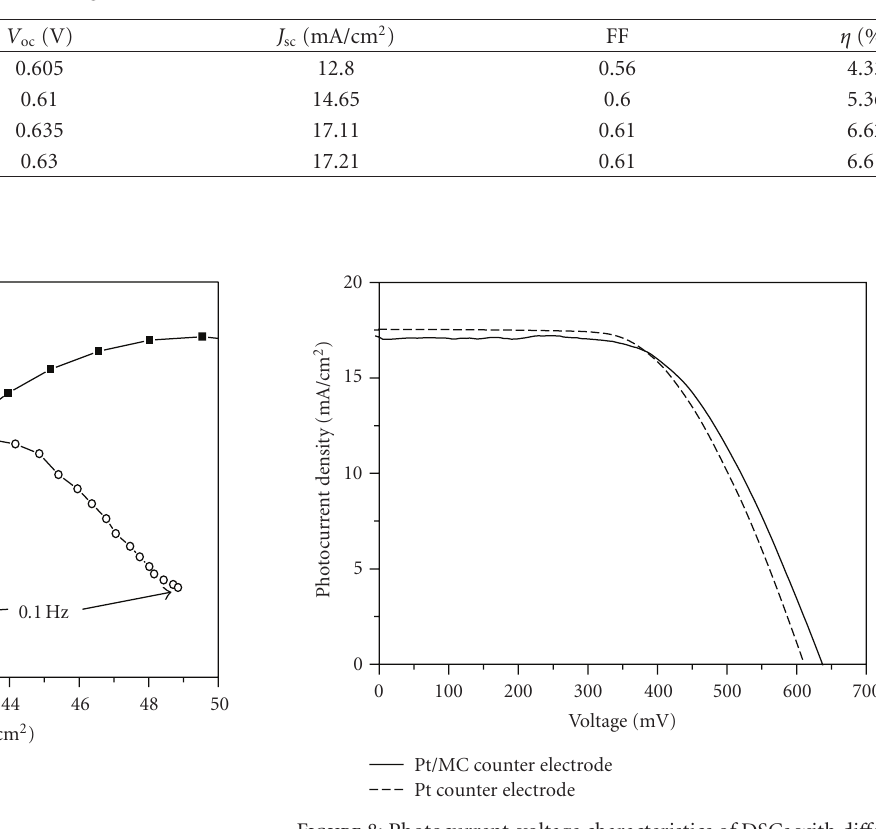
Figure 8: Photocurrent-voltage characteristics of DSCs with di ff er- ent counter electrode measured in the electrolyte as in Figure